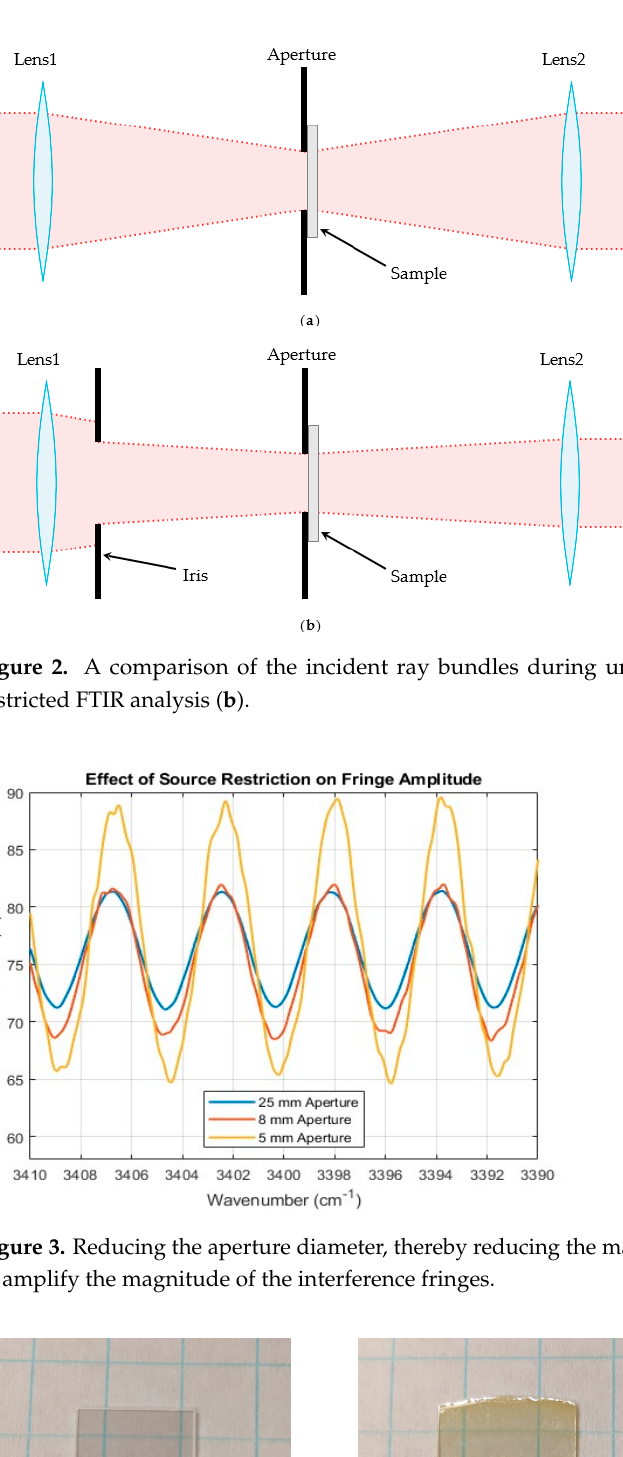
Figure 3. Reducing the aperture diameter, thereby reducing the maximum angle of incidence, serves to amplify the magnitude of the interference fringes.